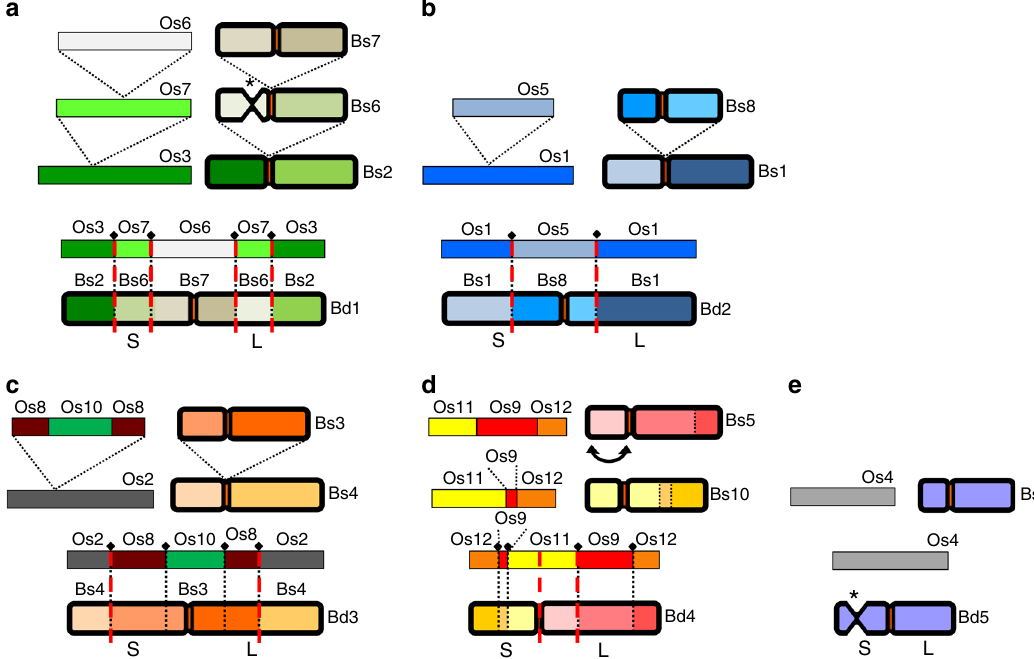
Fig. 3 Chromosome evolution inferred from cytomolecular analysis. Color-coded representation of the syntenic relationship between the fi ve B. distachyon Bd21 chromosomes and the corresponding B. stacei ABR114 chromosomes and ancestral rice chromosome equivalents. a – c The relationship between B. distachyon chromosomes Bd1 to Bd3 and the corresponding B. stacei chromosomes can be explained by a series of nested insertions of whole ancestral chromosome equivalents into centromeric regions (Bd1: Bs7 → Bs6 → Bs2; Bd2: Bs8 → Bs1; Bd3: Bs3 → Bs4). d Chromosome Bd4 shows the synteny of chromosomes Bs5 and Bs10 with the occurrence of a pericentromeric inversion in Bd4. e Chromosome Bd5 is highly collinear with Bs9. The asterisks indicate the location of the secondary constriction/satellite region in Bd5 and Bs6, which carry 35S rDNA